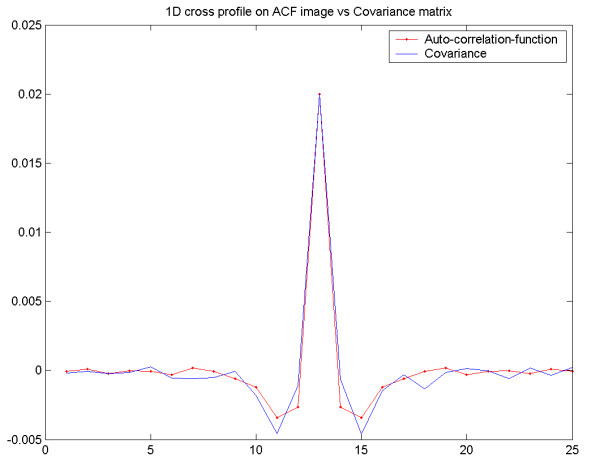
Shows 1D profile through the centre of ACF (dash dot curve) and covariance matrix (solid curve) from the study using synthetic images.